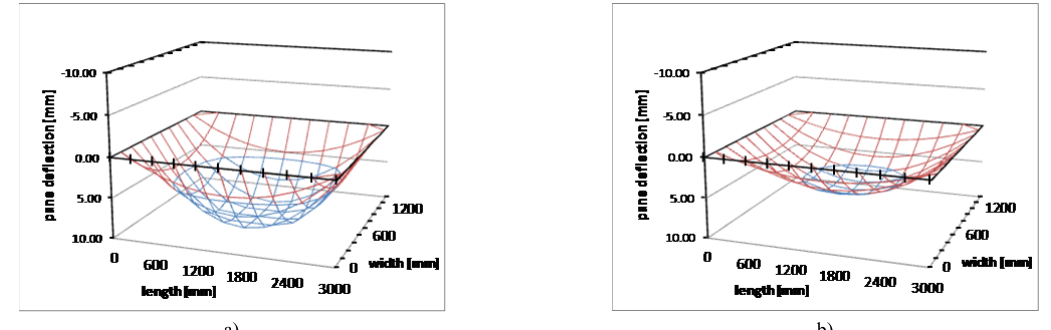
Fig. 12 Deflection of IGU glass panes (1500 x 3000 mm) with aluminum spacer , a) ext. pane, b) int. pane